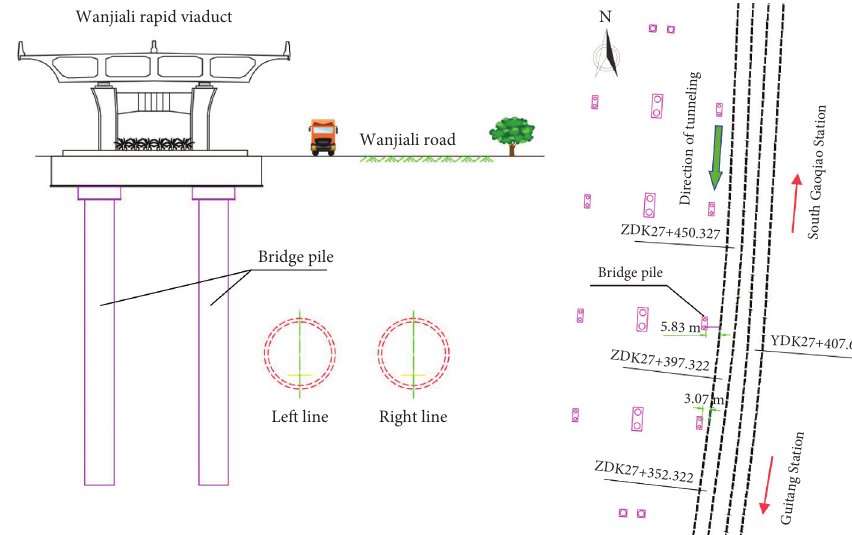
Figure 2: Location of the bridge pile and shield tunnel.